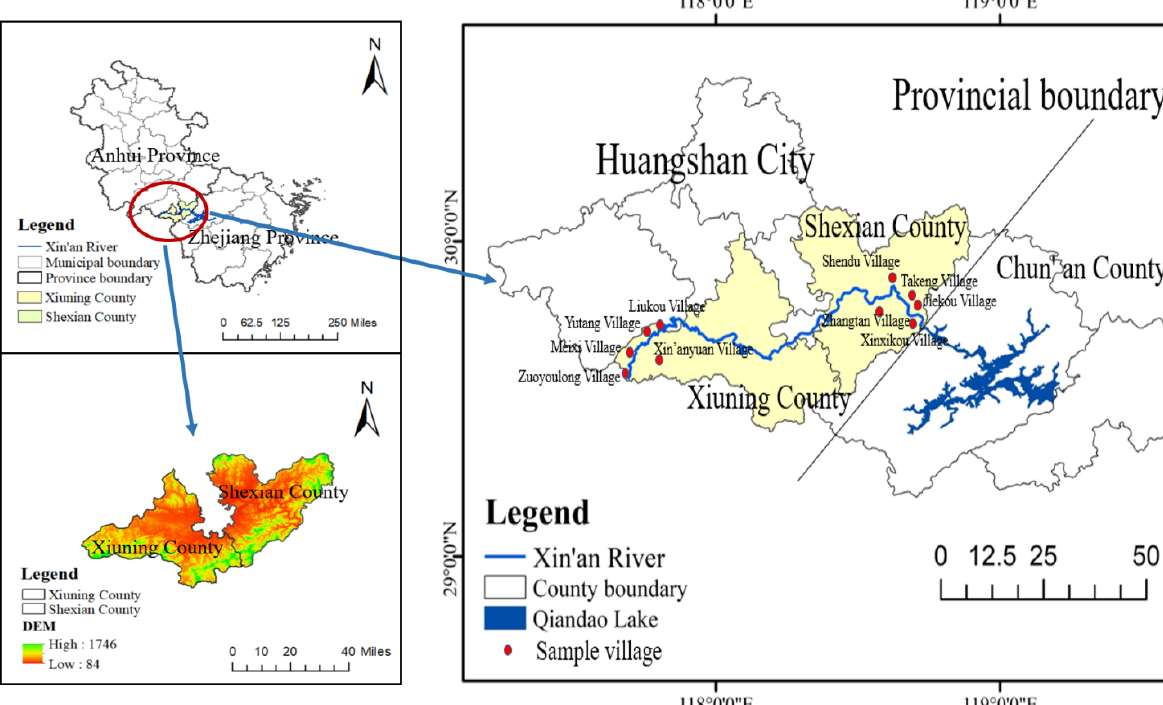
Figure 1. Study area in China.